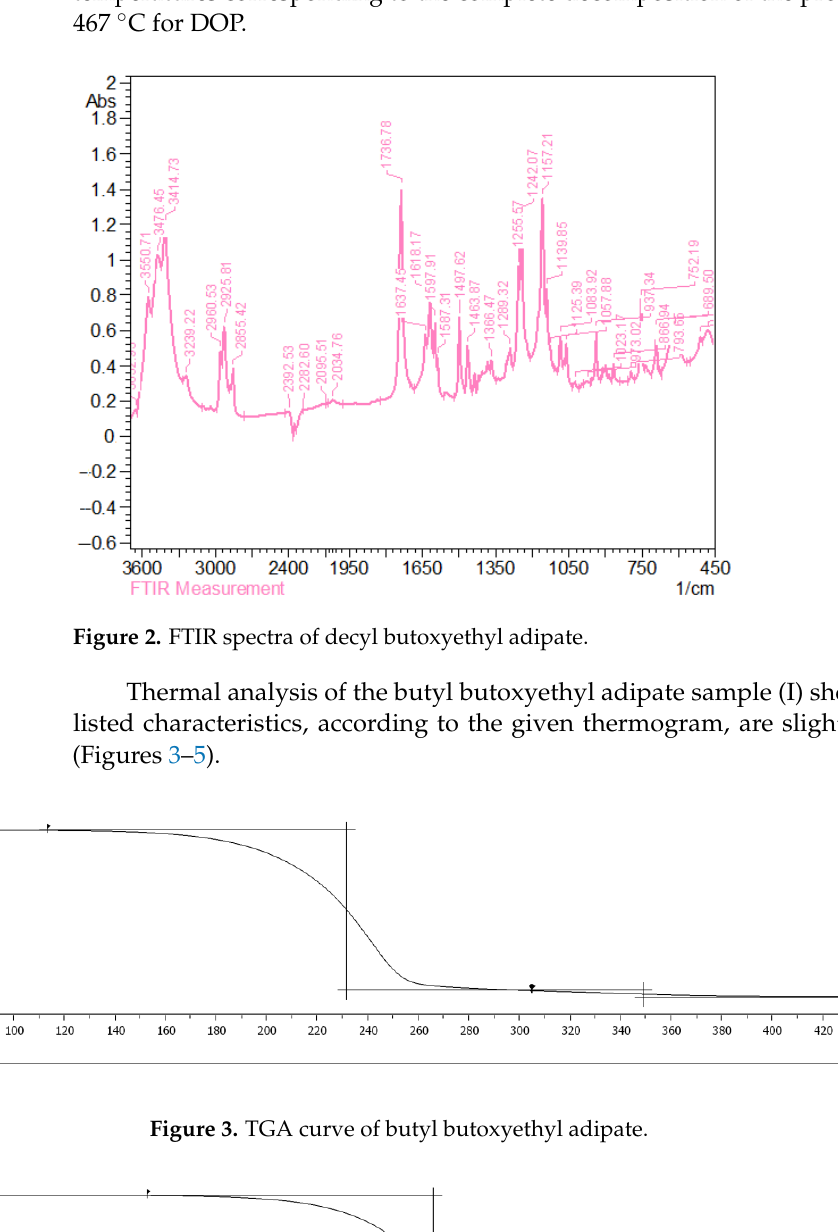
Figure 1. FTIR spectra of butyl butoxyethyl adipate.